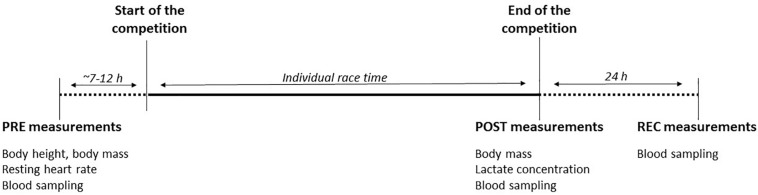
Timeline of measurements. PRE, baseline measurements performed ∼7–12 h before race start; POST, post-race measurements performed within 10 min after finishing; REC, recovery measurements performed 24 h after individual finishing. Recorded parameters are given for each measurement.